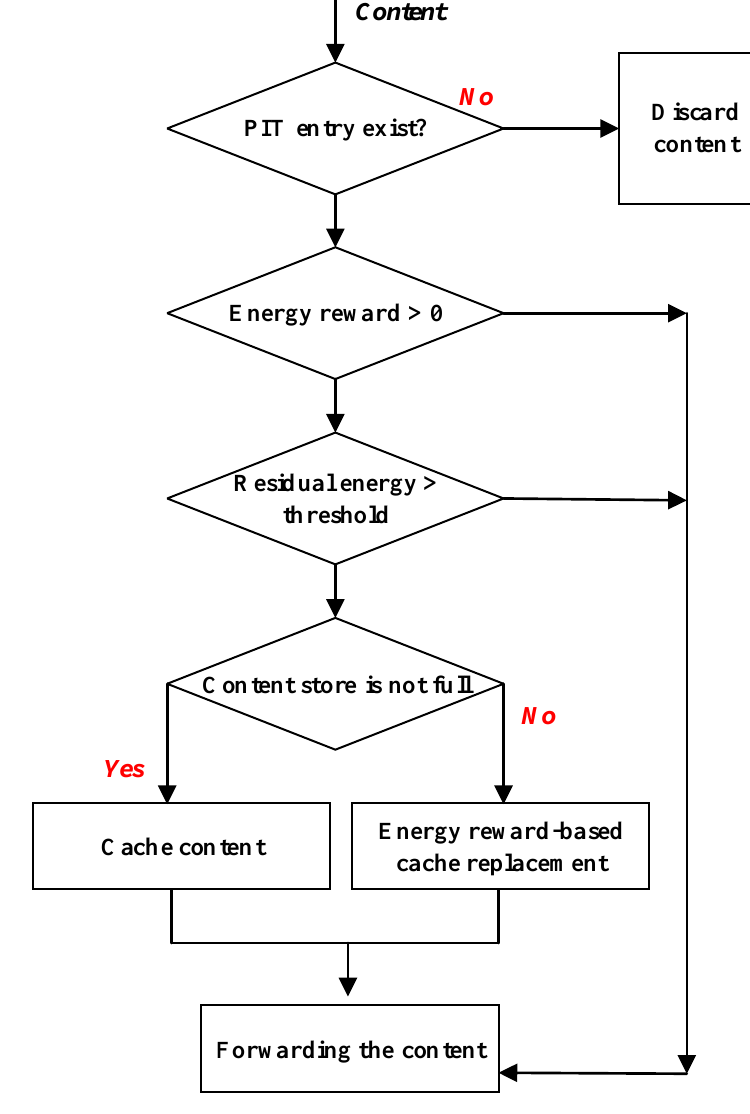
Figure 1. The processing of content objects in the proposed ERC